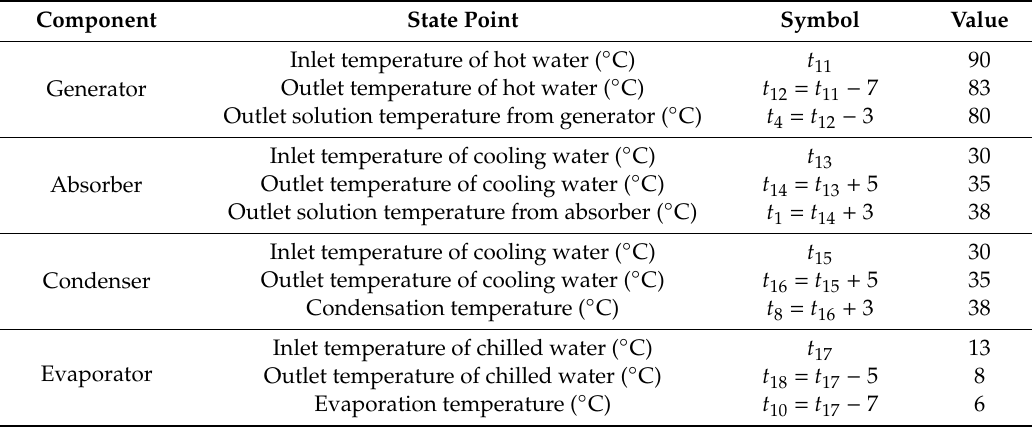
Table 1. Design temperatures of state points in the